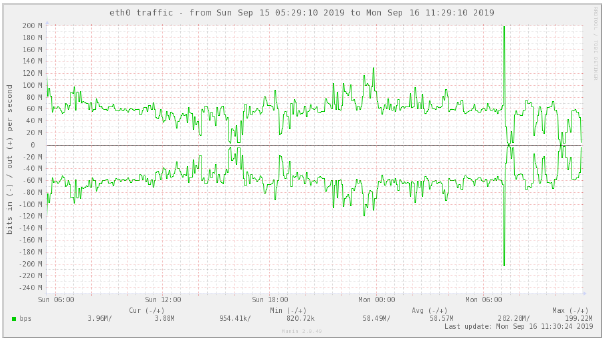
Figure 2. Network tra ffi c at one of the ARC-CE machines (each bin is 5 min) reaching saturated state at ∼ 60 Mbps. The majority of the tra ffi c is caused by the